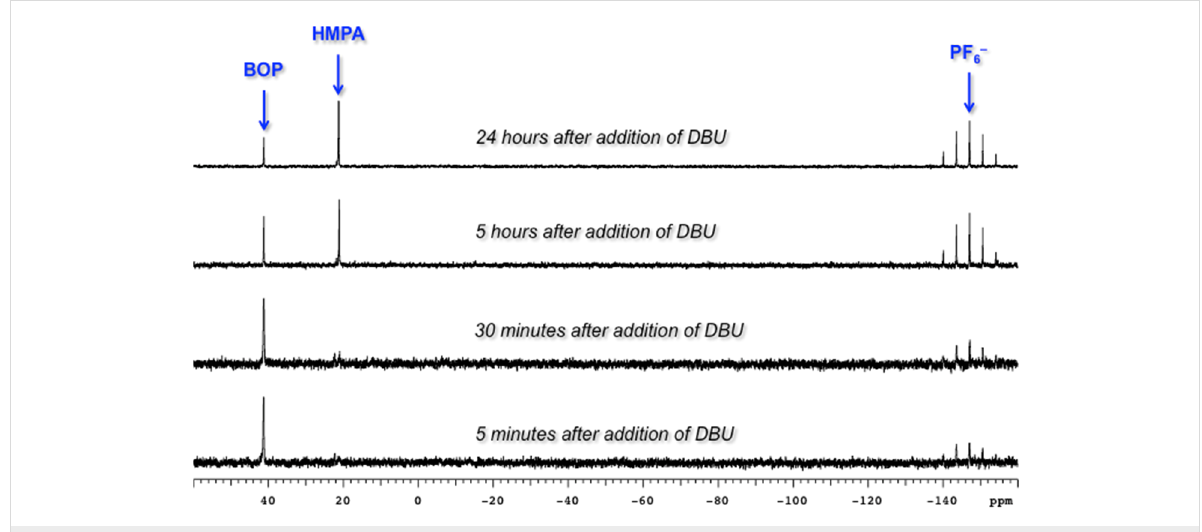
Figure 2: Evaluation of the reaction between 2-phenylethanol and BOP by 31 P{ 1 H}